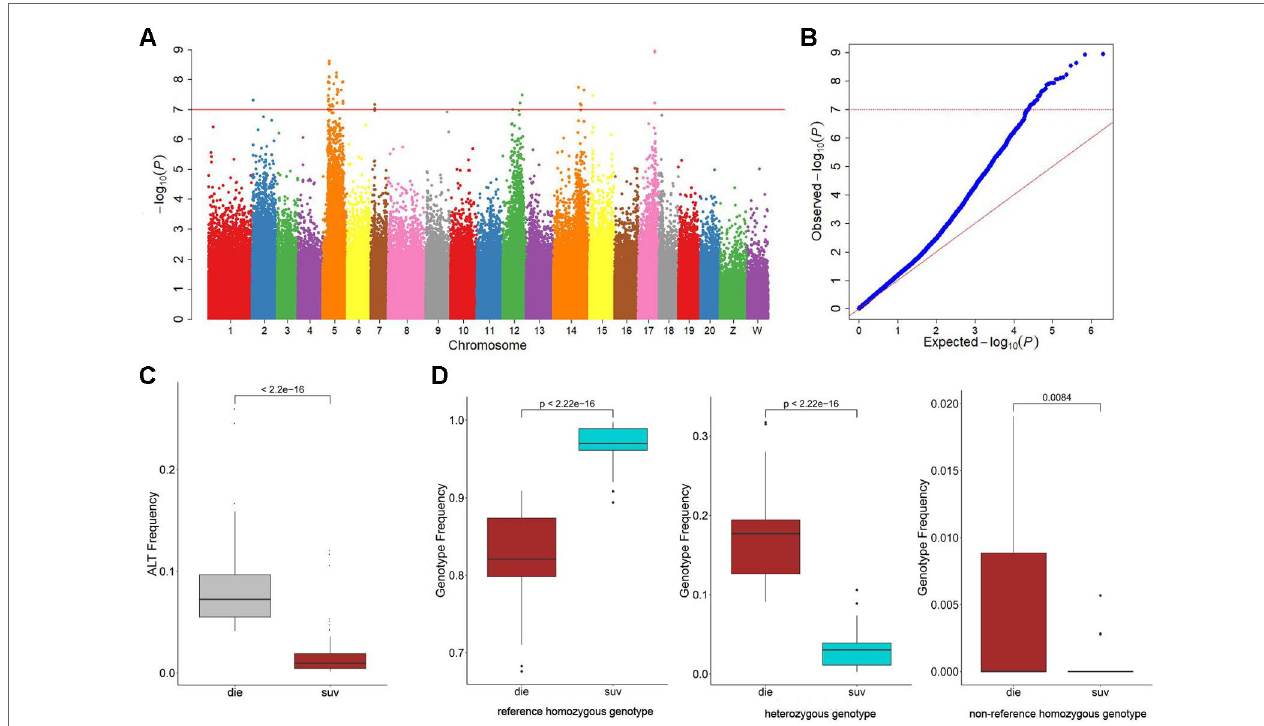
FiGURE 1 | Genome-wide association study (GWAS) results of the resistance to Vibrio harveyi infection in Cynoglossus semilaevis . (A) Manhattan plot for binary phenotypes: survival and death. The red line indicates the Bonferroni-corrected significant threshold (−log 10 p = 7). (B) Quantile-Quantile plot of the GWAS. (c) Boxplot for the mutational allele frequency of the GWAS identified single-nucleotide polymorphisms (SNPs). The statistical significance was calculated with the Wald test ( p < 10 −35 ). (D) Boxplots for the genotype frequencies of the GWAS identified